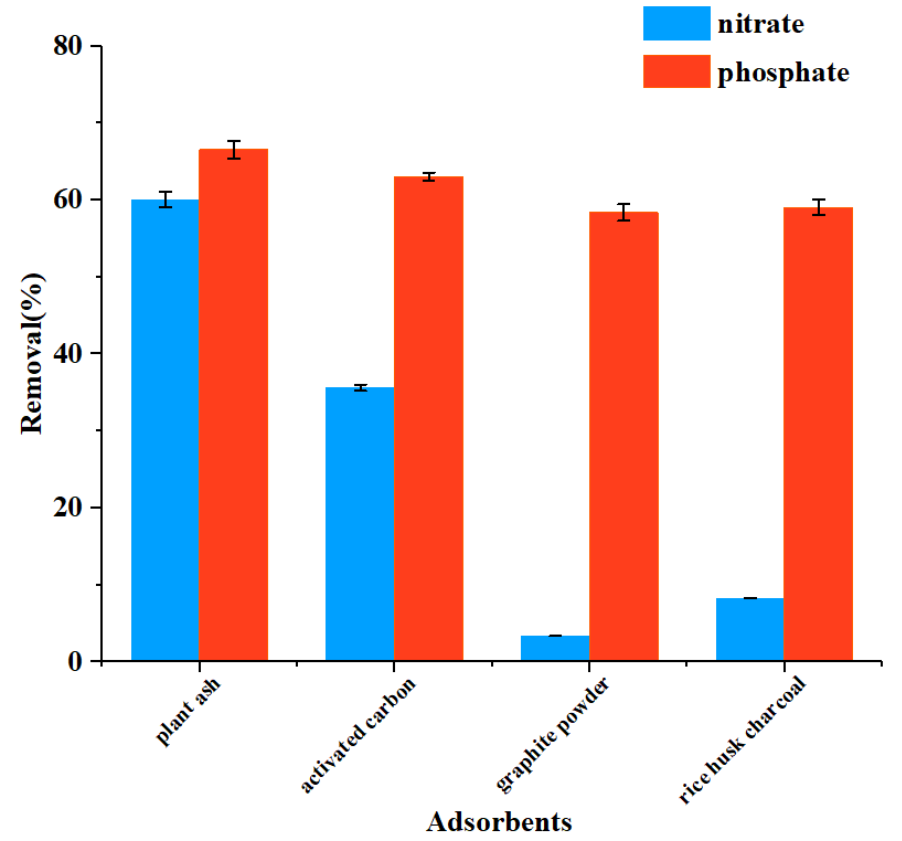
Figure 2. Effects of different adsorbents at 100 g/L on the removal of nitrate and phosphate (100 mL, 100 mg/L) after 24 h adsorption.